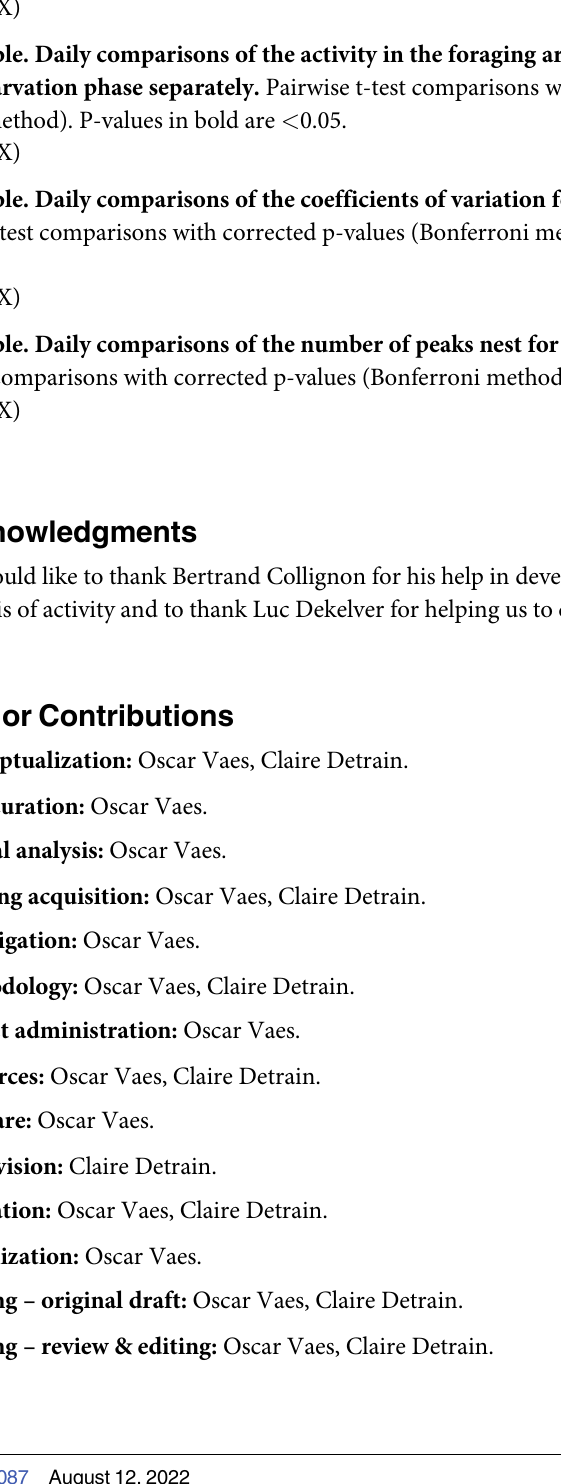
phase. CI = Confidence Interval. P-values in bold are < 0.05. S4 Table. Daily comparisons of the activity inside the nest for the starvation phase and the recovery phase separately. Pairwise t-test comparisons with corrected p-values (Bonferroni method). P-values in bold are < 0.05. S5 Table. Daily comparisons of the activity in the foraging area for the satiation phase and the starvation phase separately. Pairwise t-test comparisons with corrected p-values (Bonfer- roni method). P-values in bold are < 0.05. S6 Table. Daily comparisons of the coefficients of variation for the starvation phase. Pair- wise t-test comparisons with corrected p-values (Bonferroni method). P-values in bold are < 0.05. S7 Table. Daily comparisons of the number of peaks nest for the starvation phase.